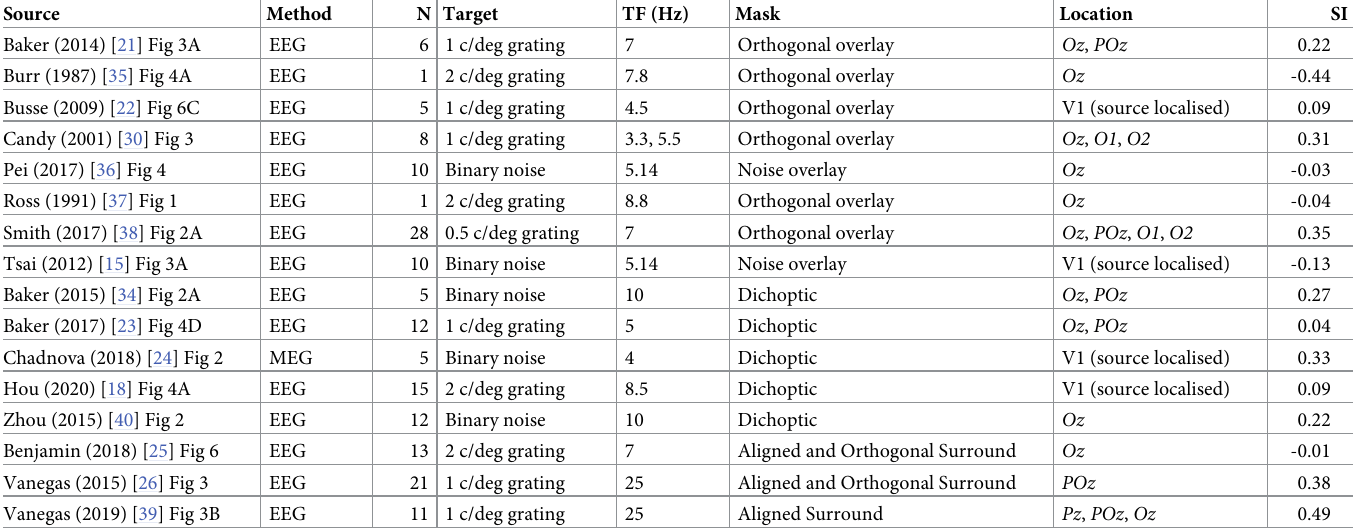
Table 1. Table summarising methodological details for each study in the meta analysis. N: number of participants, SI: saturation index.